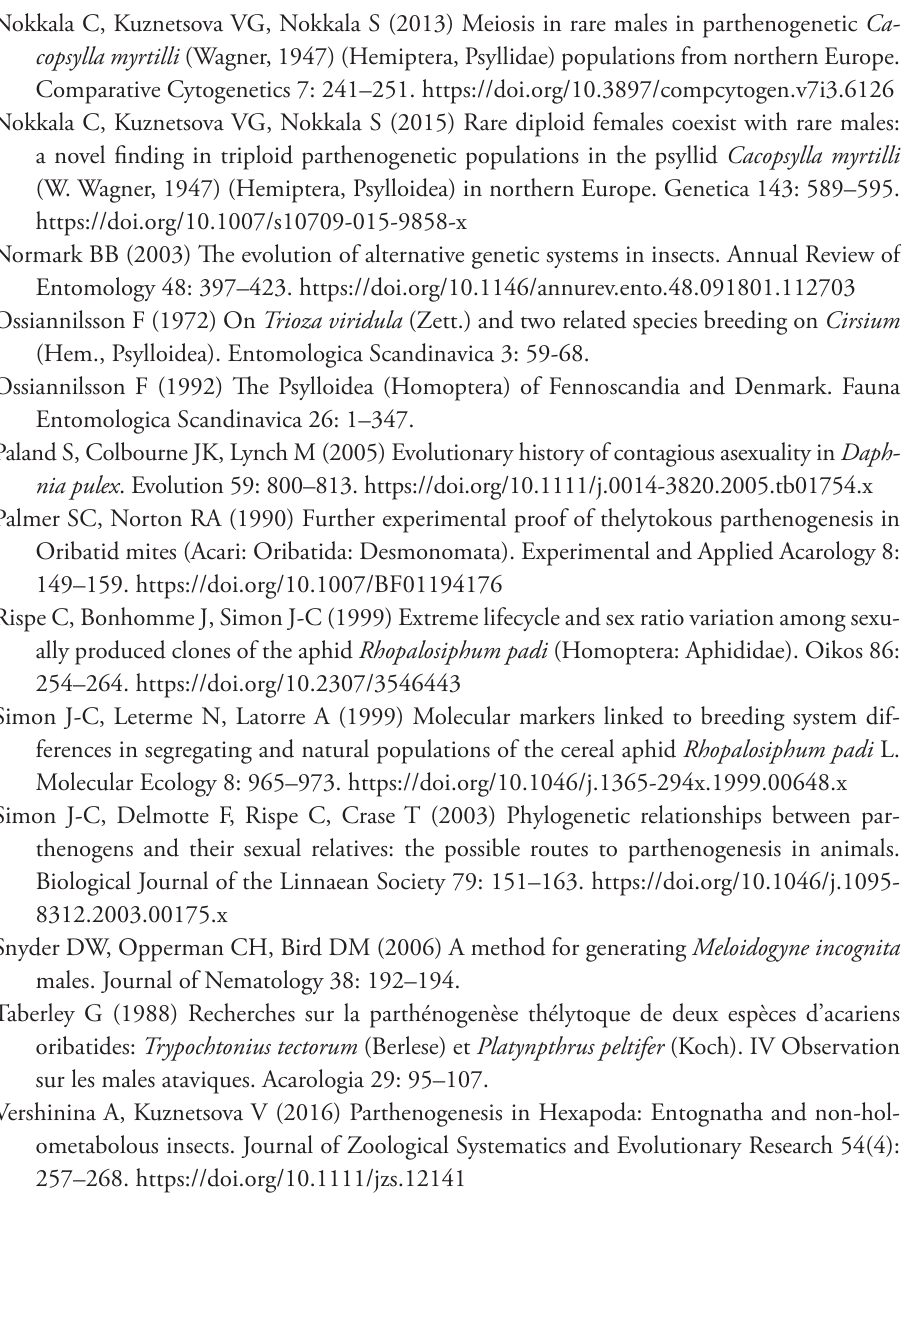
Taberley G (1988) Recherches sur la parthénogenèse thélytoque de deux espèces d’acariens oribatides: Trypochtonius tectorum (Berlese) et Platynpthrus peltifer (Koch). IV